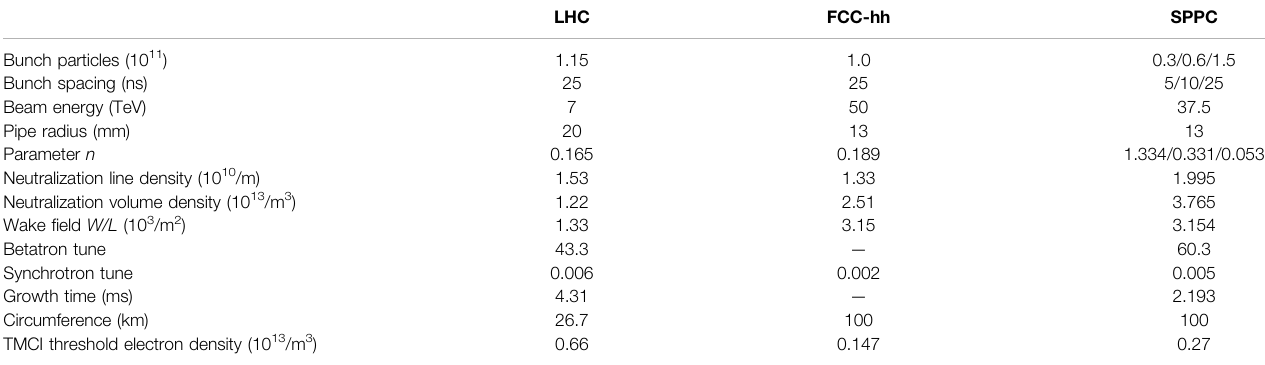
TABLE 4 | Estimates on electron cloud instability for some proton-proton colliders [19 –